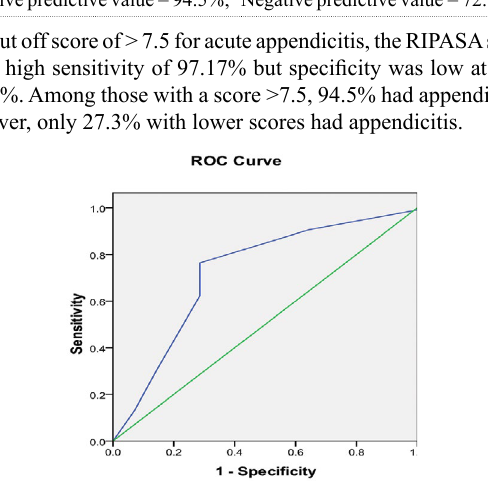
Figure 2: ROC curve for Modified Alvarado score